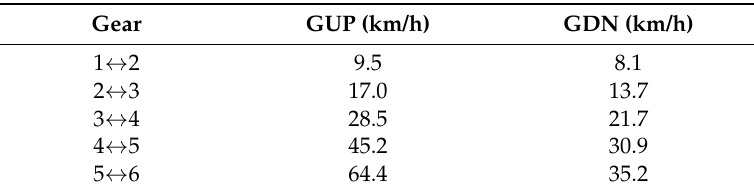
Table 4. Gear-shifting rules of the HHV.